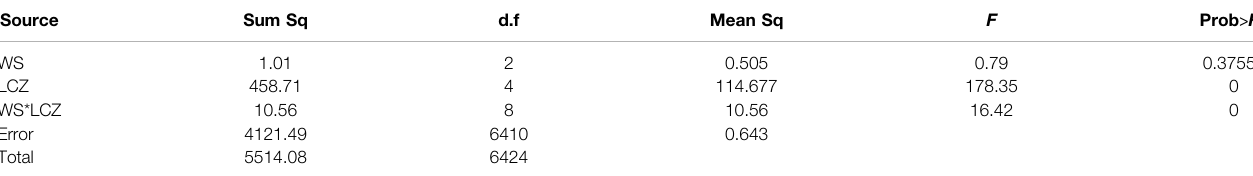
TABLE 2 | Two-way analysis of variance between wind speed and LCZs to UHII. Source